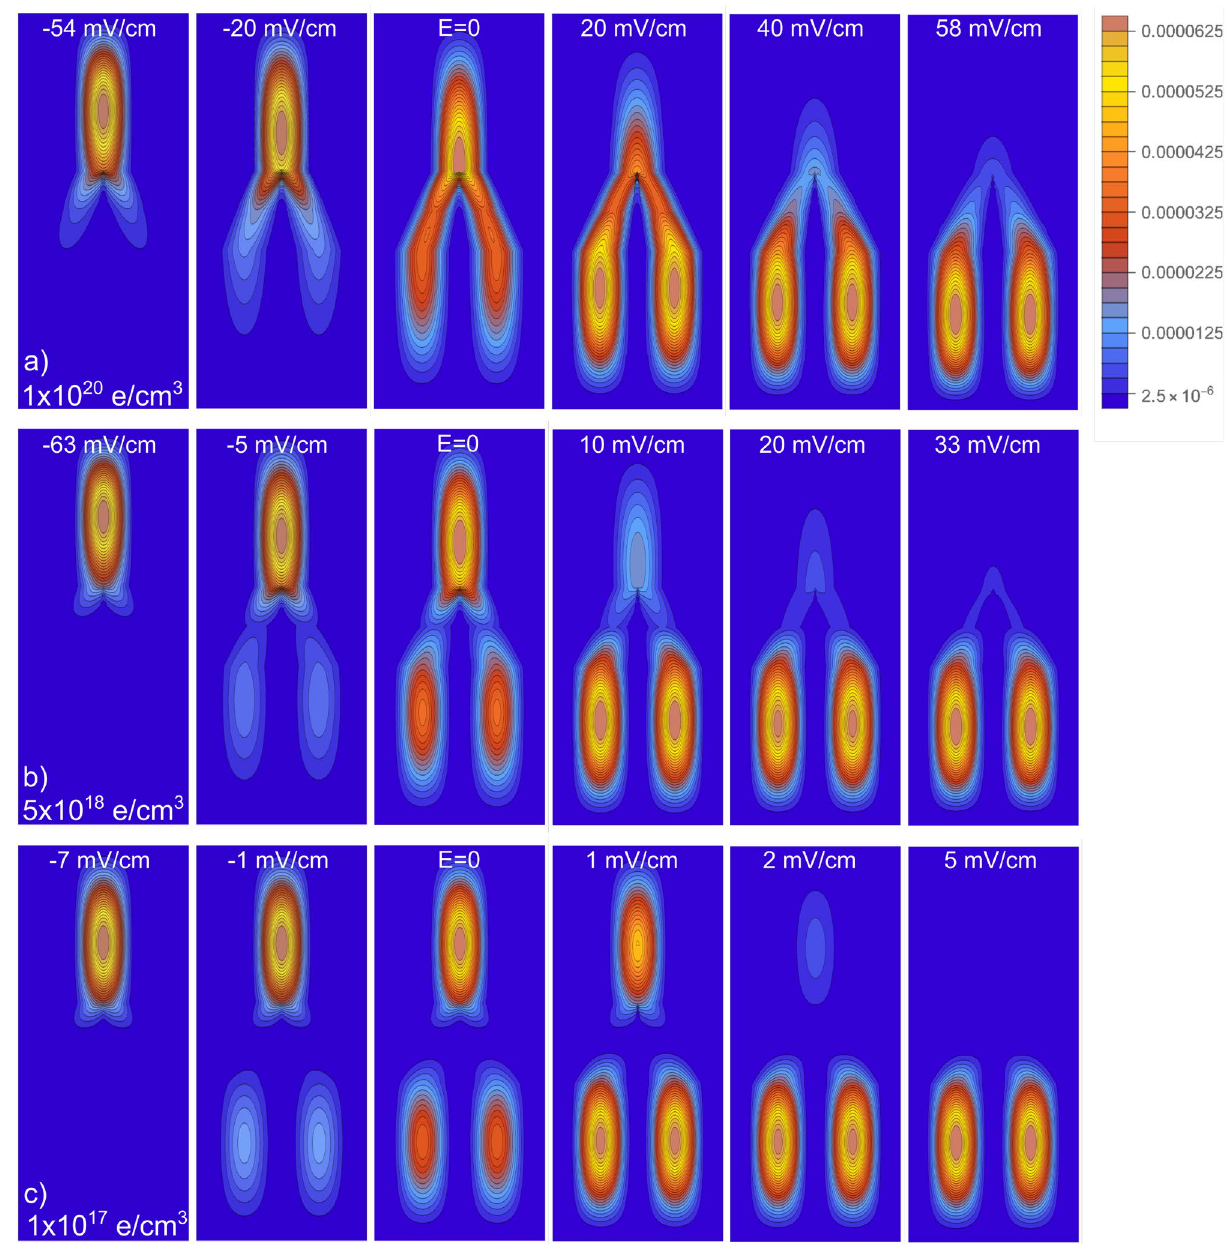
Figure 6. Ground state x – z projections of the charge distribution probability Y-Js of L x , y = 25 nm, L b = 10 nm, and length L z = 2 µ m. Density n varies from row to row: ( a ) 1 × 10 20 electrons/ cm 3 , ( b ) 5 × 10 18 electrons/ cm 3 , and ( c ) 1 × 10 17 electrons/ cm 3 . The electric field magnitude applied along the z -axis is indicated in each figure. x and z scales are the same as the ones in Fig.